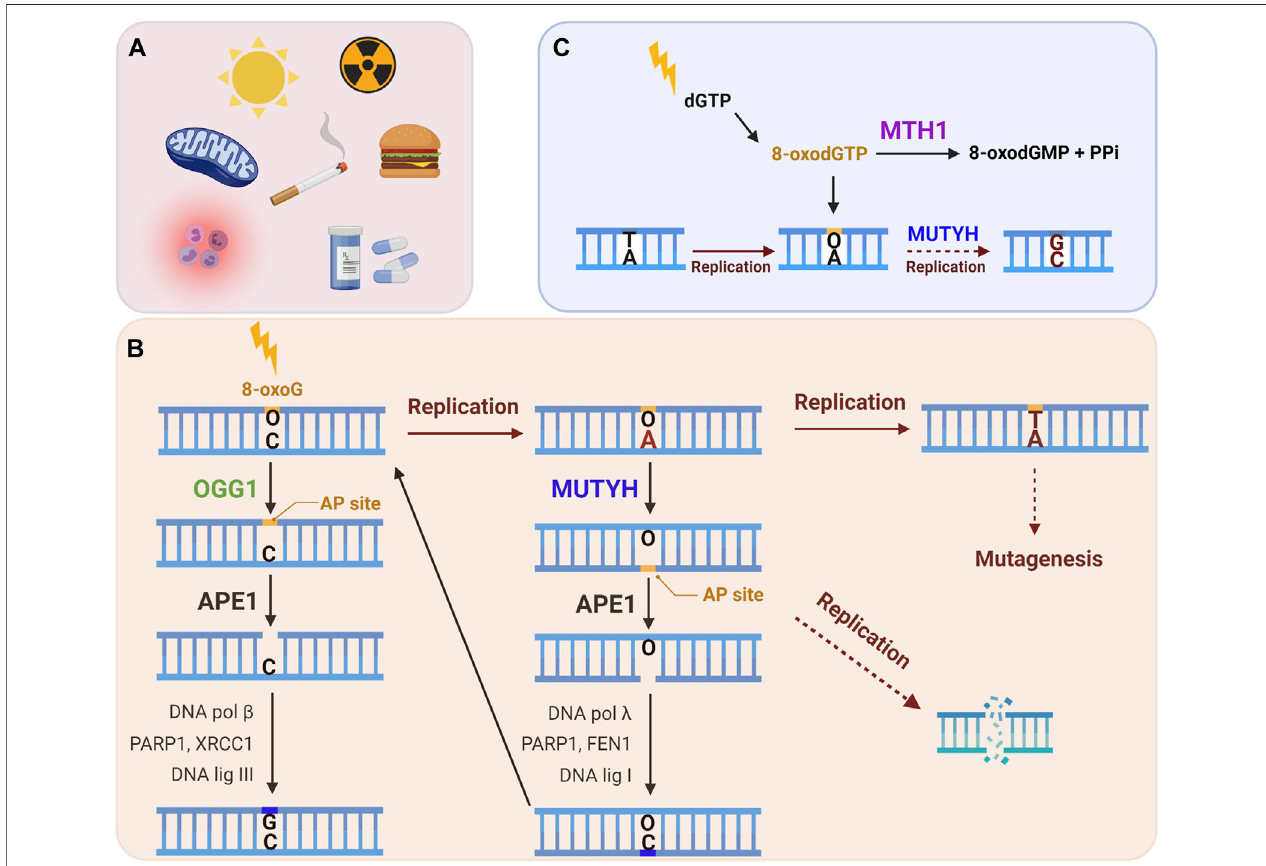
FIGURE 2 | The human GO repair system. (A) 8-oxoG lesion is among the most common forms of oxidative DNA damage, which can arise following exposure to endogenous and/or exogenous ROS. (B) An 8-oxoG:C base pair isrecognized and excised by the OGG1 glycosylase, producing an apurinic (AP) site, which is cleaved by APE1, and then processed by downstream BER to restore the correct G:C base pair. If 8-oxoG escapes repair it can miscode for adenine upon DNA replication. MUTYHglycosylaserecognizesa8-oxoG:Amispairandexcisestheundamagedadenine,therebyinitiatinglong-patchBERtorestorethe8-oxoG:Cbasepair.This allows OGG1 another chance to excise 8-oxoG and to initiate BER to restore the G:C base pair. If the 8-oxoG:A mispair is not repaired, a further round of replication converts the damage to a G:C to T:A transversion mutation. Lesion processing by BER generates repair intermediates, including AP sites and SSBs, which can cause replication fork collapse and subsequent DSBs. (C) MTH1 sanitase provides further protection against 8-oxoG mutagenesis through removing 8-oxodGTP from the nucleotidepool byhydrolyzing itto8-oxodGMP and pyrophosphate. This preventsmisincorporation of8-oxodGTPopposite atemplate adenine during DNA replication or repair. The mismatch repair (MMR) enzymes (not shown) can also eliminate 8-oxoG from newly synthesized DNA that has been misinserted opposite adenine. (Black arrows: canonical repair steps. Brown arrows: Rounds of replication. Dashed arrows: mutagenesis or DNA damage generating steps).